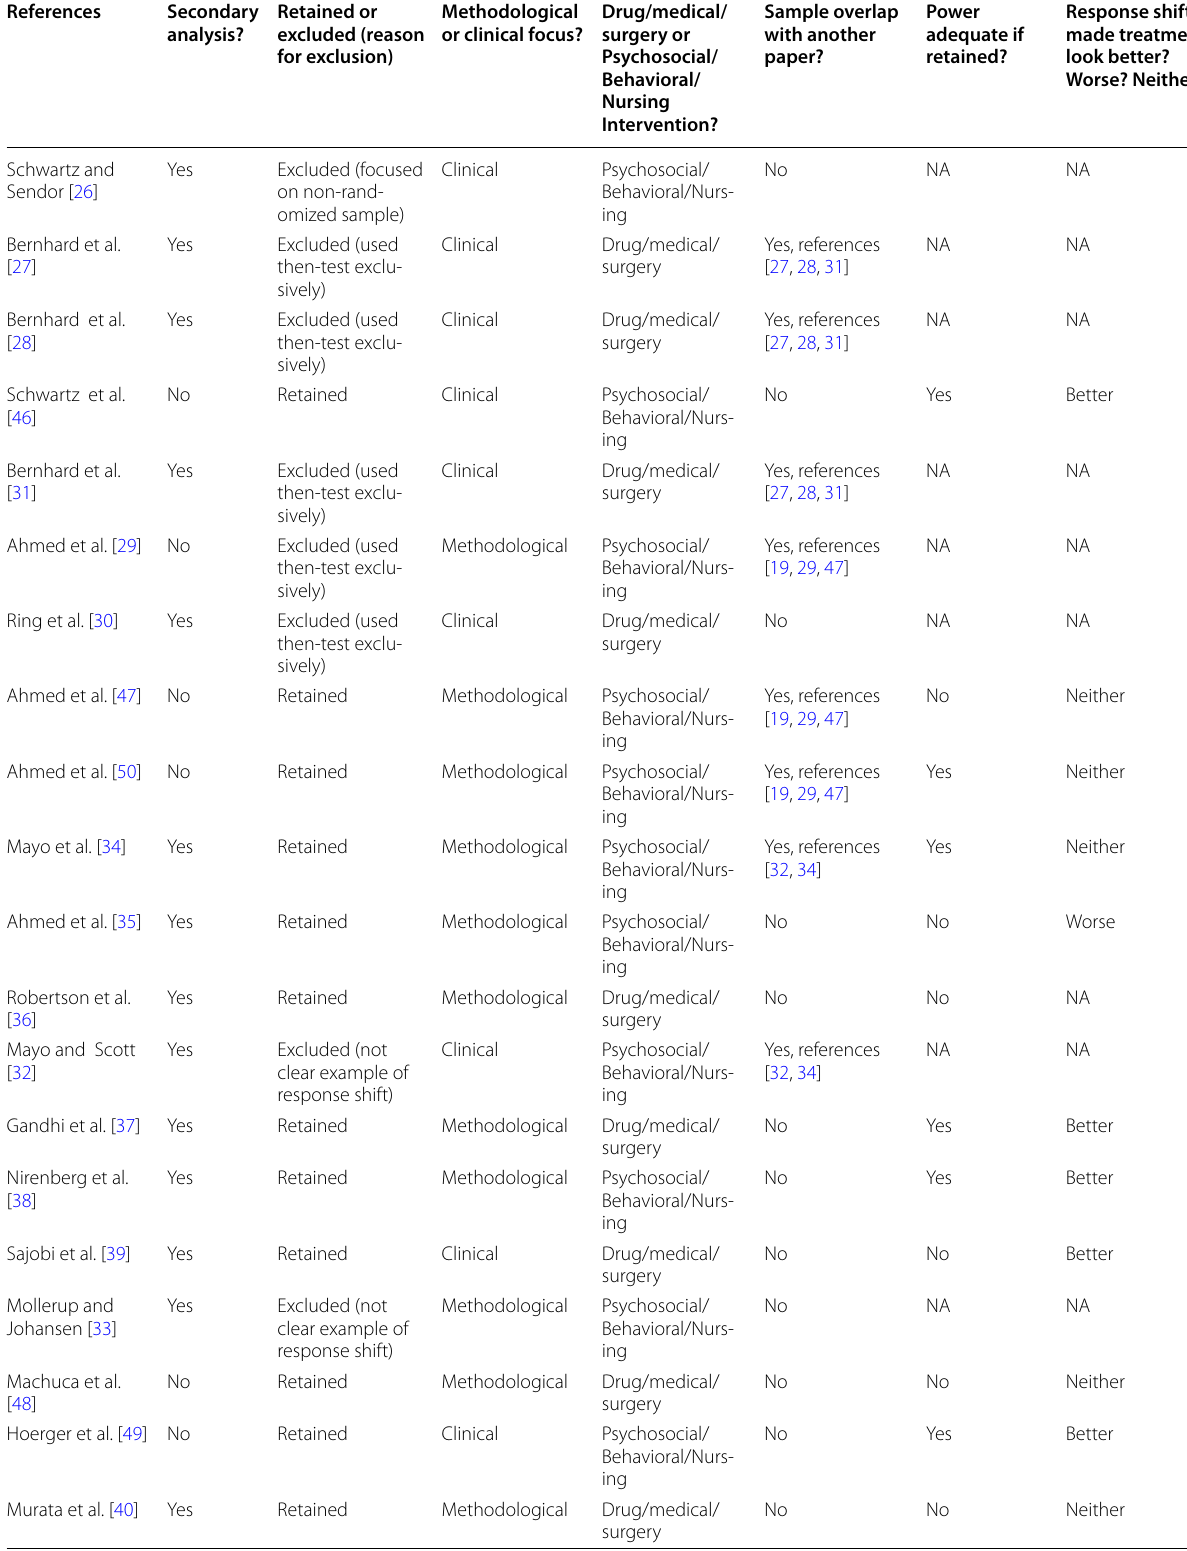
Table 1 Clinical Trials Articles Found After Initial Inclusion/Exclusion Criteria